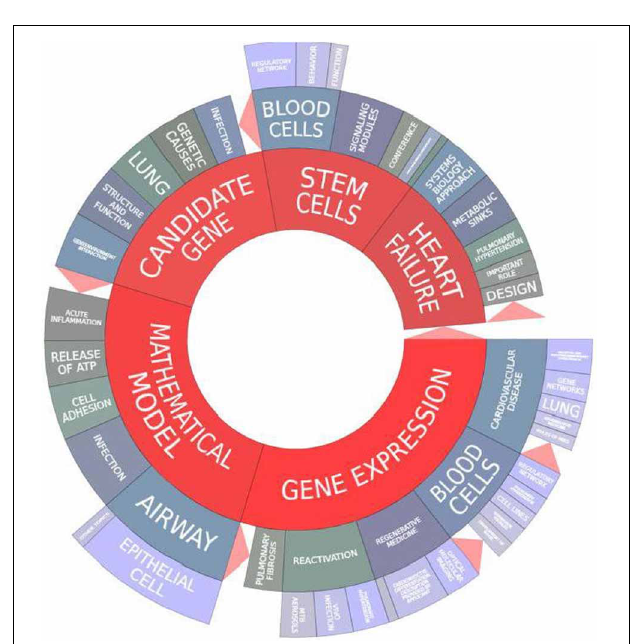
publications-Legend-Publications from the targeted FOAs gain impact in 1–3 year lag following funding, continuing to increase through 2011, although funding peaked for targeted FAOs in 2008. (D) Amount of $ on grants/year-Legend- Through 2008, virtually all funding goes to the RFA awards. However other (non-FOA) systems biology grants accelerate rapidly from 2009 to 2012.